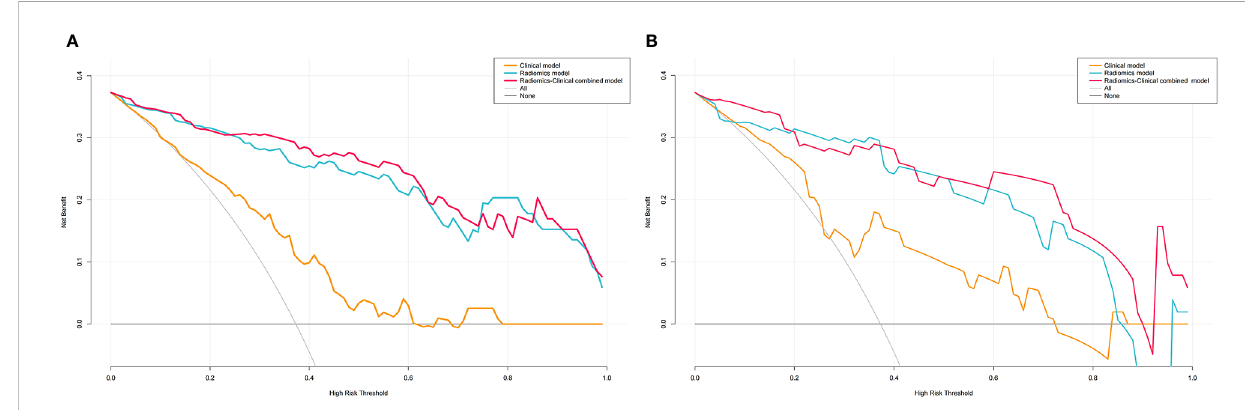
FIGURE 9 DCA for Clinical, Radiomics and Radiomics-Clinical nomogram in the training (A) and validation (B)